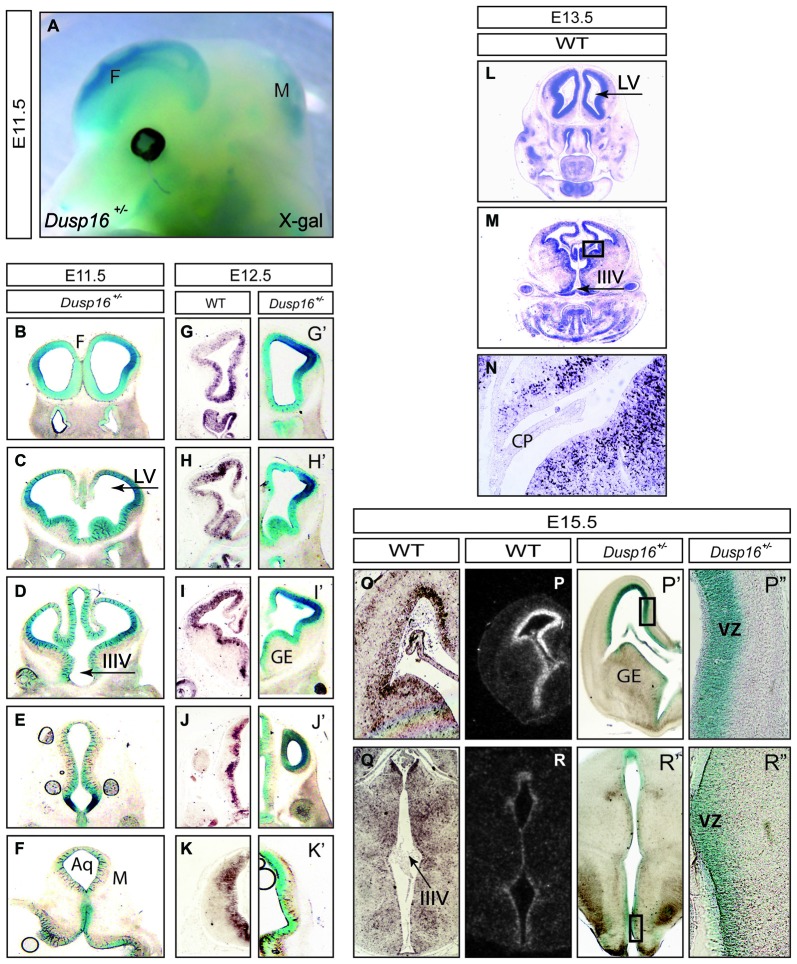
Dual-specificity phosphatase 16 (Dusp16) is highly expressed in the VZ of the embryonic mouse brain. (A) X-Gal staining of an E11.5 embryo head expressing the LacZ gene under the endogenous Dusp16 promoter. Dusp16 is strongly expressed in the forebrain and dorsal midbrain at E11.5. (B–K′) Serial rostral to caudal coronal sections of E11.5 and E12.5 Dusp16+/− embryos demonstrate strong expression of Dusp16 in the VZ of developing brains shown by lacZ staining and mRNA in situ hybridization. (L–N) mRNA in situ hybridization using a Dusp16 mRNA probe demonstrates that Dusp16 continues to be expressed also at E13.5 and E15.5 (O–R), that corresponds to lacZ staining at E15.5 (P′,P″,R′,R″). CP, choroid plexus; F, forebrain; IIIV, third ventricle; LV, lateral ventricle; M, midbrain; VZ, ventricular zone; GE, ganglionic eminence; Aq, Aqueduct of Sylvius.